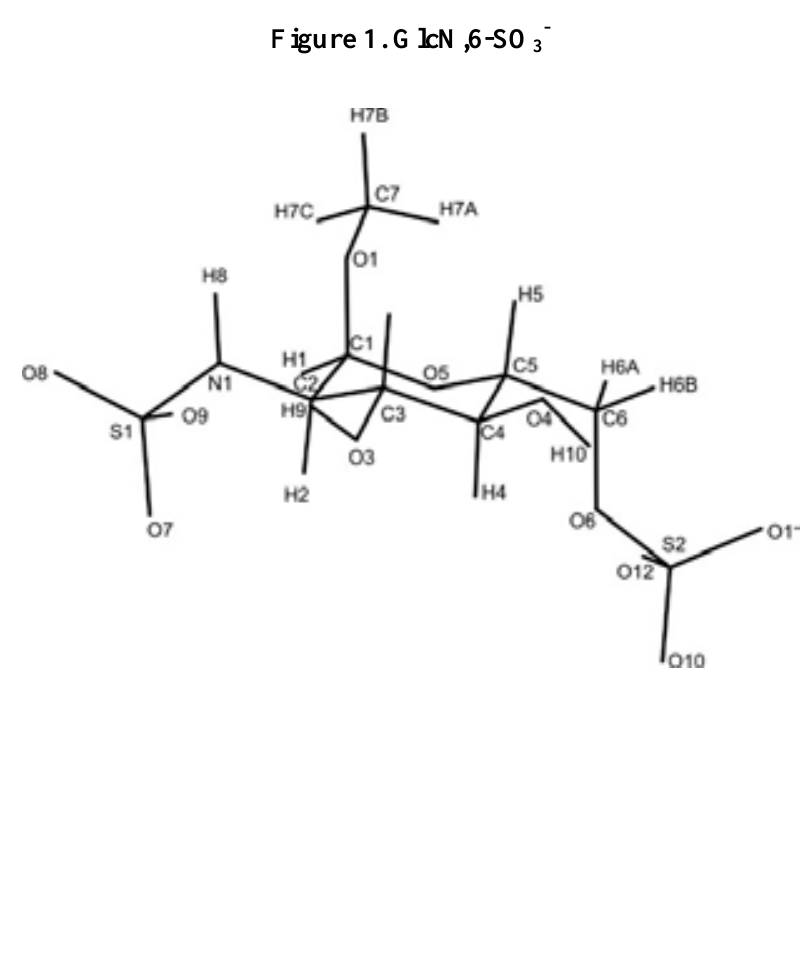
Figure 1. GlcN,6-SO